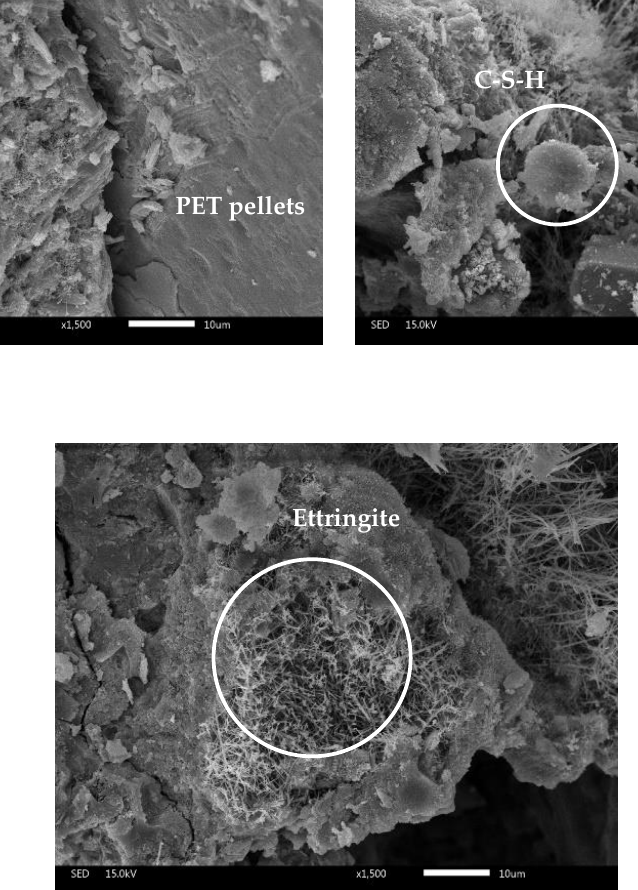
Figure 12. Microstructure of mortar specimens: control ( a ), A0P10 ( b ), A0P20 ( c ), A40P0 ( d ), and A40P20 ( e ).